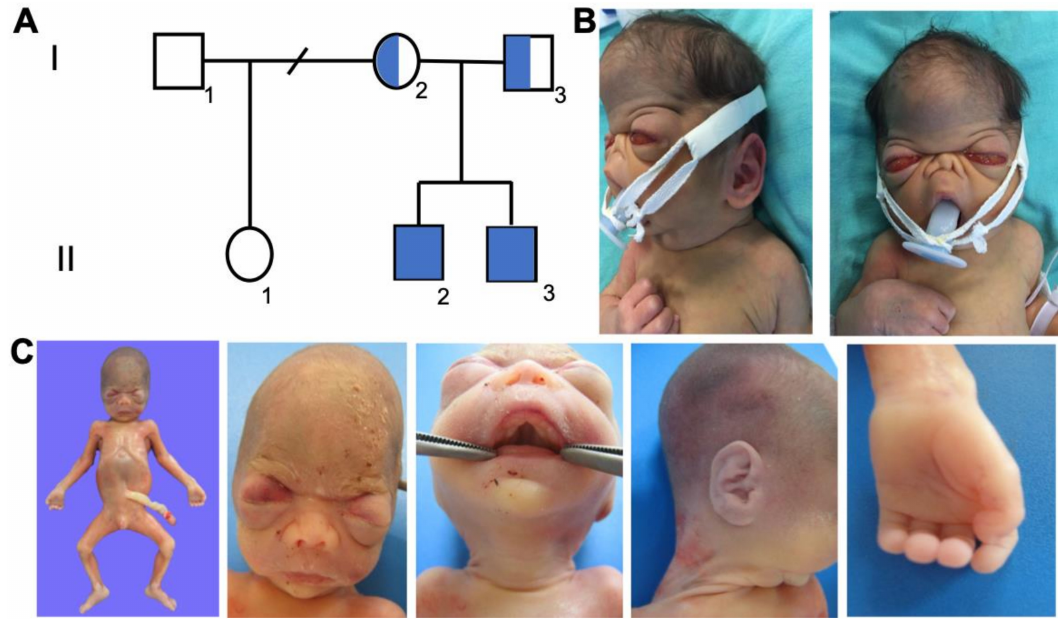
Figure 1. Family pedigree and phenotype of a ff ected siblings (case 1 and 2). ( A ) Pedigree of the family showing reported cases (case 1 corresponds to individual II.2 and case 2 corresponds to individual II.3). ( B ) Clinical picture of the first proband (case 1). ( C ) Clinical pictures of the second patient (case